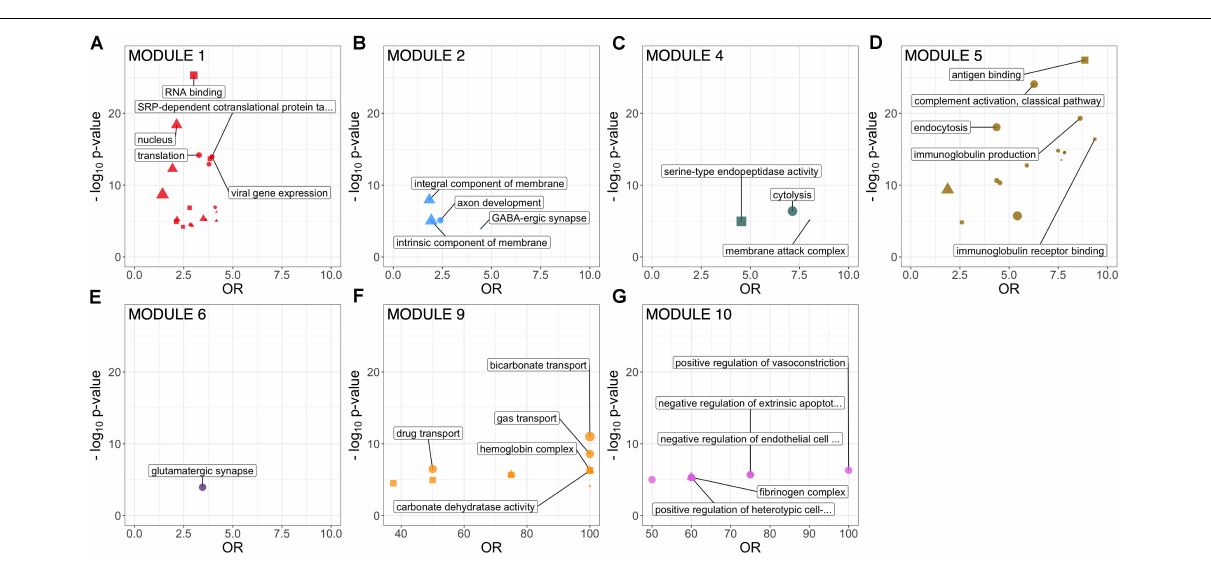
FIGURE 2 | GO term enrichment of identified CSF protein network modules (FDR-adjusted p < 0.1). Size proportional to number of annotated proteins within a GO term in that module. Top 5 GO terms by p -value are labeled. All significantly enriched GO terms are detailed in Supplementary Table 1 . CSF, cerebrospinal fluid; GO, Gene